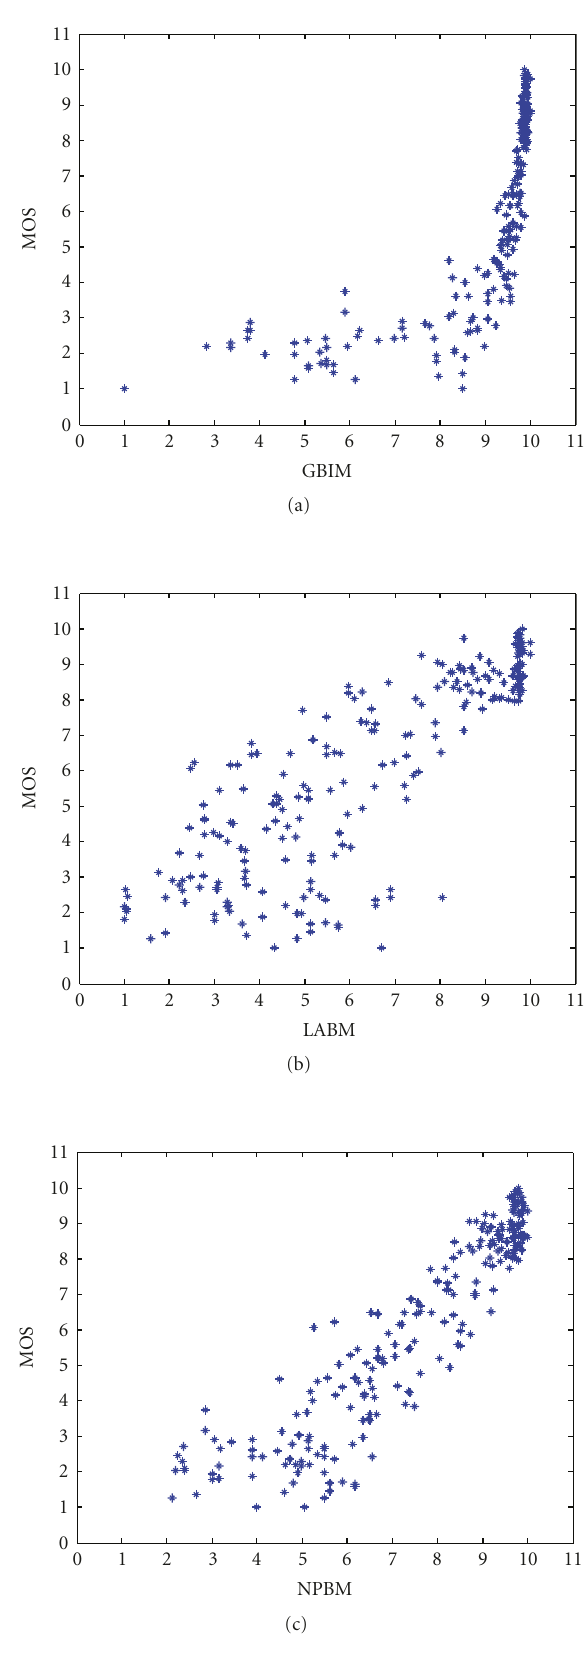
Figure 10: Scatter plots of MOS versus blockiness